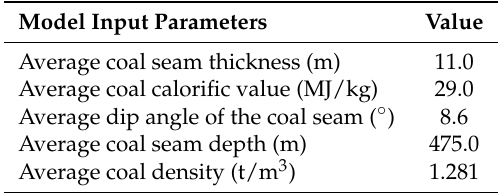
Table 1. Geological data of the target coal seam, adapted from Otto et al.